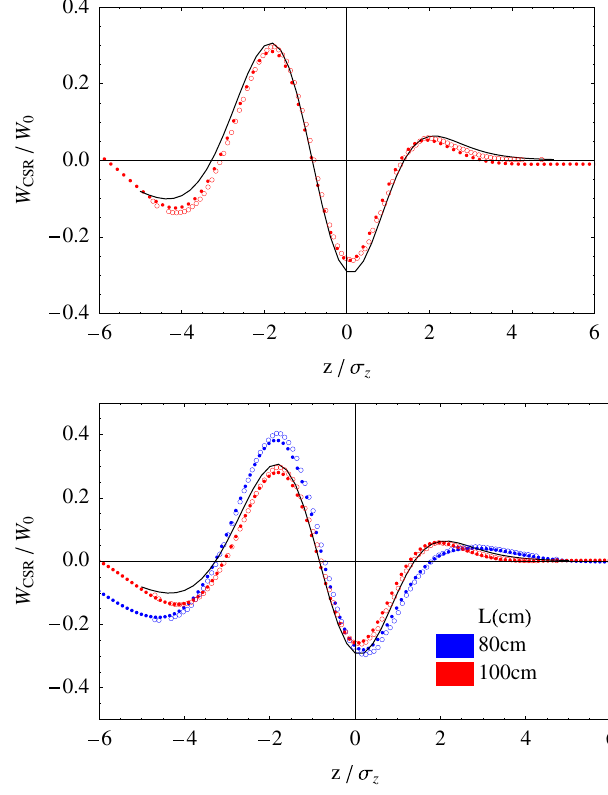
FIG. 13. (Color) The same as Fig. 9, except with the chamber height reduced to 2 cm. A&Y code (dots), Bmad (circles), and the shielded steady-state CSR-wake Eq. (53)